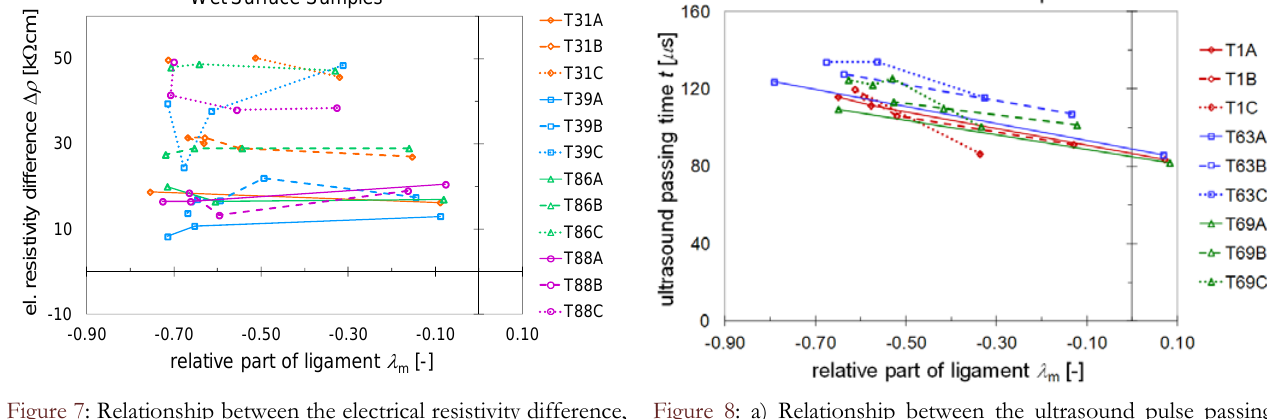
Figure 8: a) Relationship between the ultrasound pulse passing time, t , and the relative transverse distance between the effective crack tip and the measuring location,  m , for the pre-dried surface samples evaluated at the notch (n)